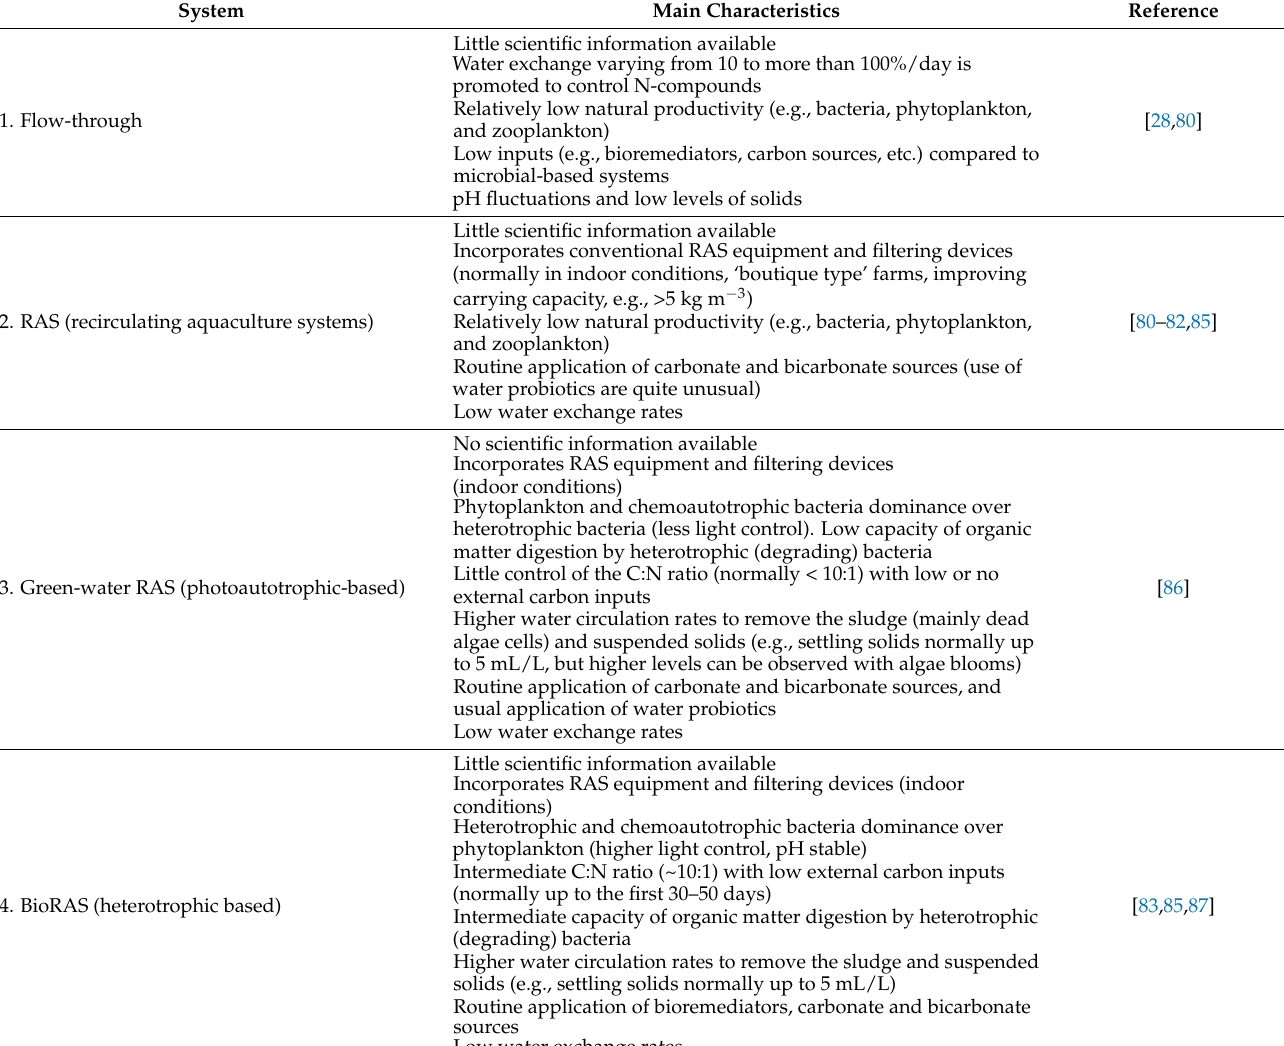
Table 2. Summary of flow-through, RAS, and hybrid systems showing the main characteristics of the systems and references. The information presented is a general guide only and may change according to regional conditions and culture